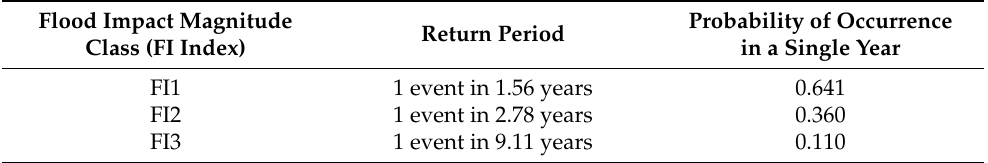
Figure 7. Yearly maximum number of flood fatalities (FFs) per flood event (FE) against their return period (T) in years Table 4. Return periods of different categories of events in terms of flood impact magnitude (FI index) across the whole study area